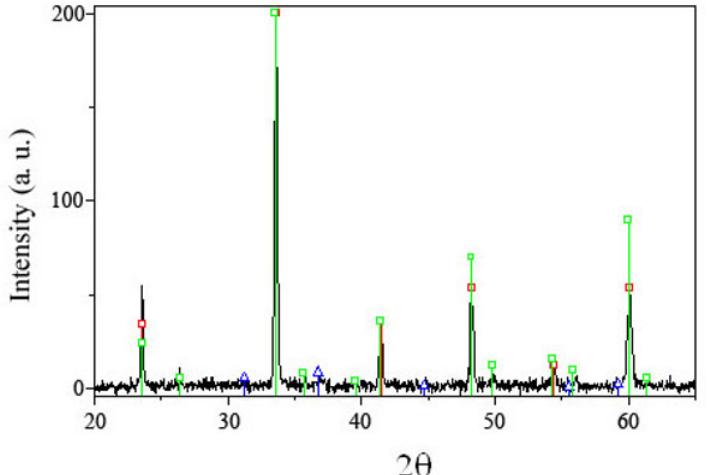
Figure 4. X-ray diffraction pattern of CoAl